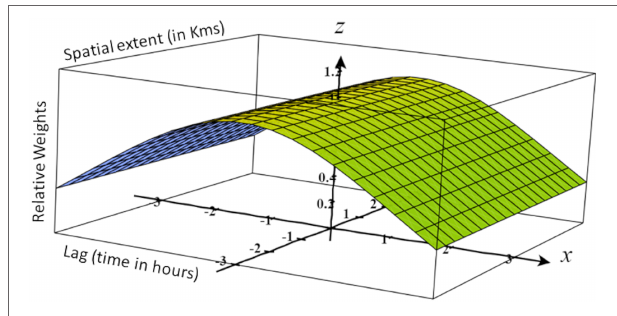
FIGURE 2 | The interpolation weight function in the space–time domain w k